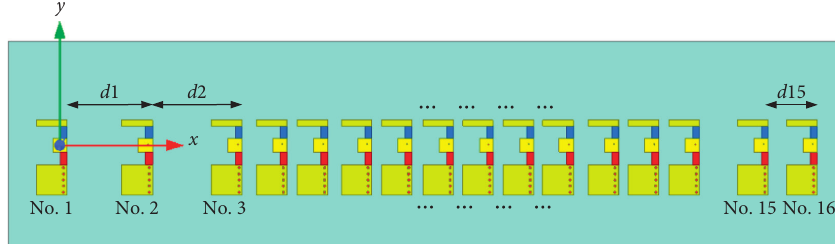
Figure 9: The schematic of the 1 × 16 linear irregular Figure 12. Corresponding to the reconstruction states of Ka- band, Ku-band, and X-band, the main polarization states are all vertical polarization, and the cross-polarization levels are − 15.8 dB, − 23.3 dB, and − 17.5 dB, respectively. Besides, the sidelobe levels are − 15.7 dB, − 17.0 dB, and − 16.2 dB, re- spectively. The FRAA gains are 18.1 dB, 17.0 dB, and 12.5 dB. In addition, the pattern beams deflection of the three states is the same; that is, θ xoz � 20 ° .